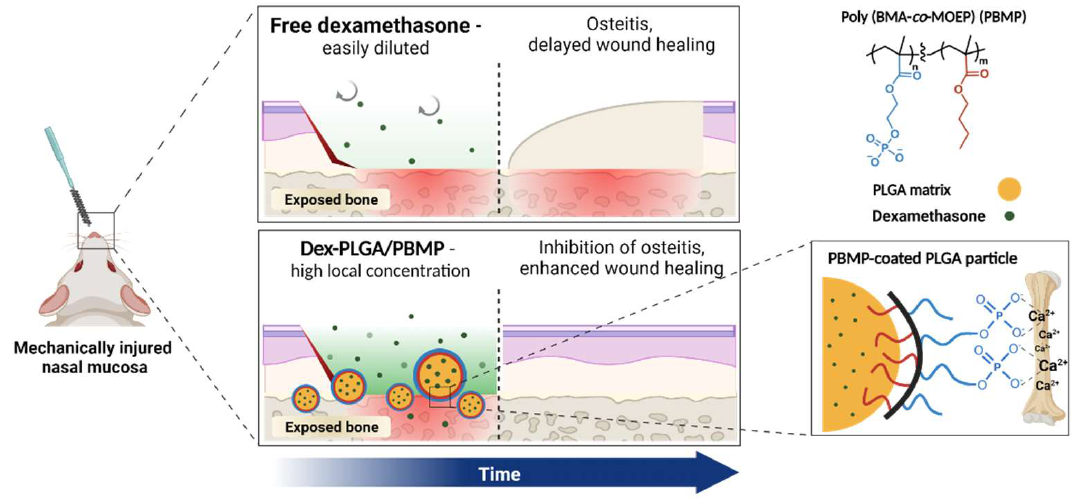
Figure 1. Schematic illustration of the Dex-loaded PLGA/PBMP microparticles on exposed bone surfaces in mouse nasal cavity for maintenance of the local Dex concentration around surgery-induced osteitis.